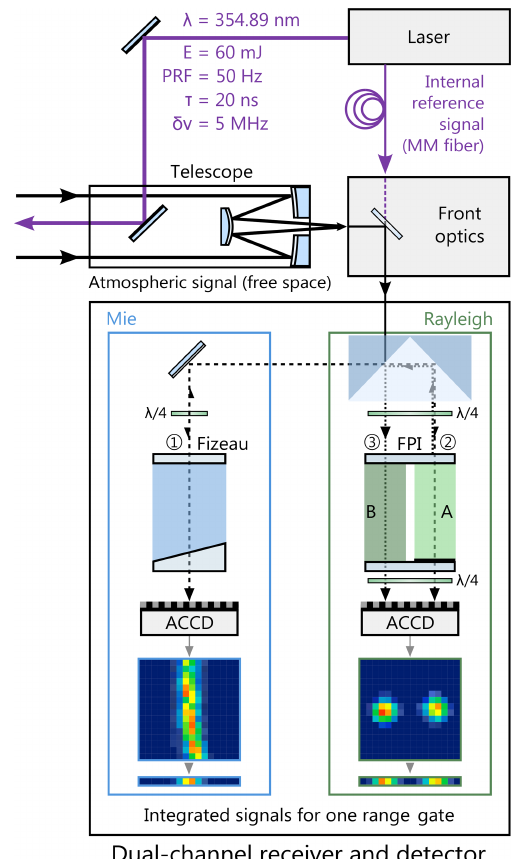
Figure 1. Schematic of the ALADIN Airborne Demonstrator (A2D) wind lidar instrument consisting of a frequency-stabilized, ultra- violet laser transmitter, a Cassegrain telescope, front optics and a dual-channel receiver. The latter is composed of a Fizeau in- terferometer and sequential Fabry–Pérot interferometers (FPI) for analysing the Doppler frequency shift from particulate and molec- ular backscatter signals respectively. PRF refers to the pulse repeti- tion frequency, MM stands for multimode and ACCD refers to the accumulation charge-coupled